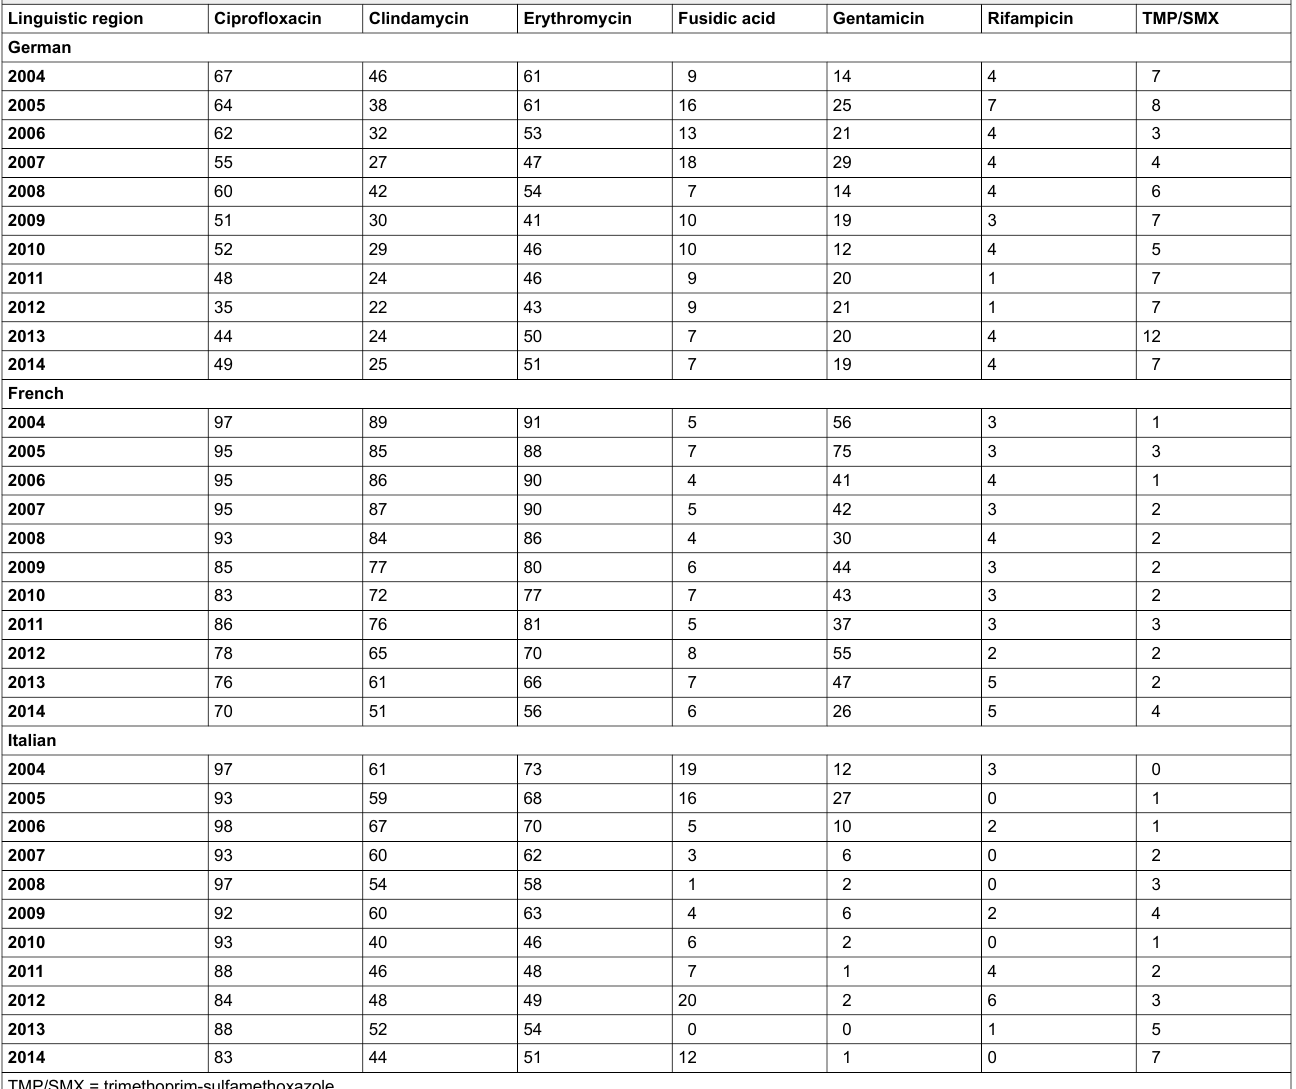
Table S2: Percentage of antibiotic resistance among MRSA